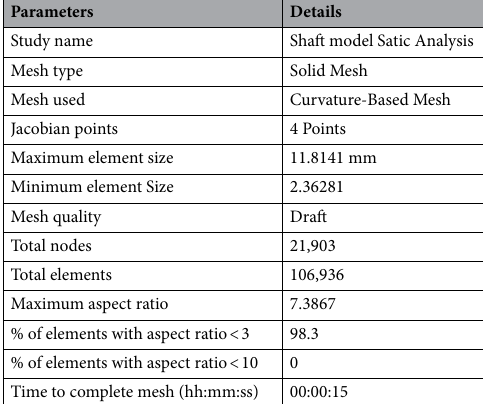
Table 9. Mesh generated details.